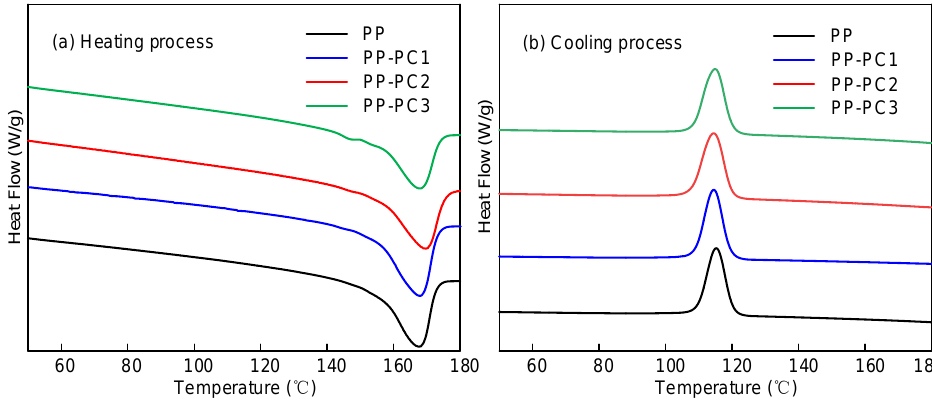
Figure 2. DSC curves of the samples: ( a ) heating process, ( b ) cooling process. The DSC of the samples was conducted from 50 to 180 °C, with the heating and cool- ing rate set at 10 °C per minute. The melting temperature can be obtained from the heating process shown in Figure 2a, and the crystallization temperature can be obtained from the cooling process shown in Figure 2b. The melting temperature (Tm), crystallization tem- perature (Tc), and enthalpy of the absorption during melting (Hm) can be obtained from Figure 2 and are presented in Table 2. The melting temperature peaks of PP-neat, PP-PC1, PP-PC2, and PP-PC3 are 167.48, 167.62, 169.60, and 167.56 °C, respectively. The addition of polycyclic compounds slightly increases the melting temperature peaks, which has lit- tle effect on the high temperature properties of PP films. The crystallization temperature peaks of PP-neat, PP-PC1, PP-PC2, and PP-PC3 are 115.31, 114.53, 114.60, and 114.91 °C, respectively. The crystallization temperature peaks of all the samples are almost the same. Crystallinity was calculated as the ratio of the absorbed enthalpy during the melting pro- cess to the enthalpy at 100% crystallinity. The enthalpy of PP at 100% crystallinity is 209 J/g. The crystallinity of PP-PC3 increased slightly, whereas the crystallinity of PP-PC1 and PP-PC2 decreased slightly. The crystallinity of all samples is above 30% with little differ- ence. Compared with PP-PC1 and PP-PC2, PP-PC3 presents a slightly improved thermal property. Table 2. Thermal parameters of samples. Sample Tm (°C) Tc (°C)